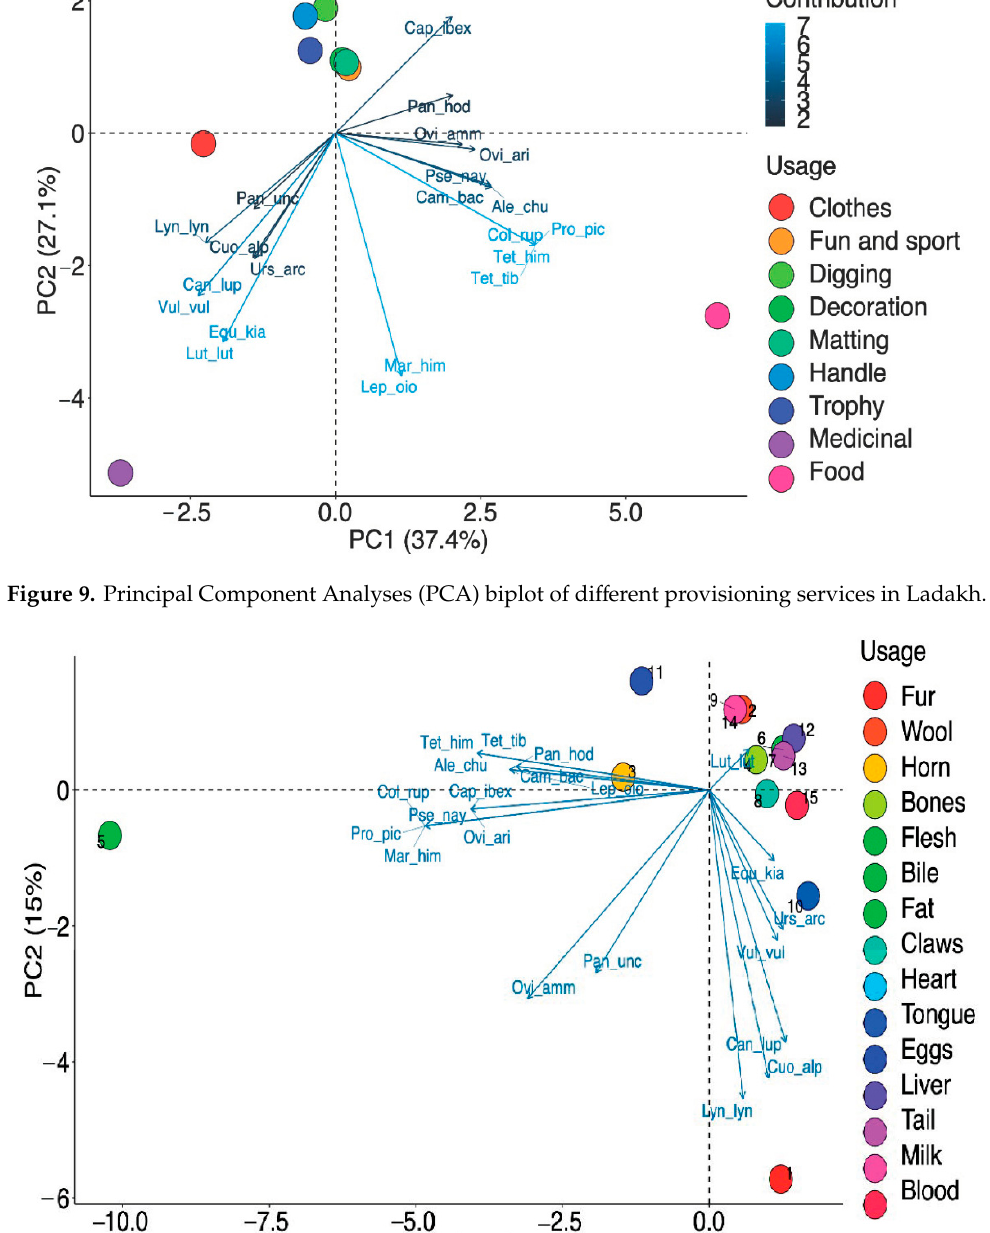
Figure 9. Principal Component Analyses (PCA) biplot of different provisioning services in Ladakh.